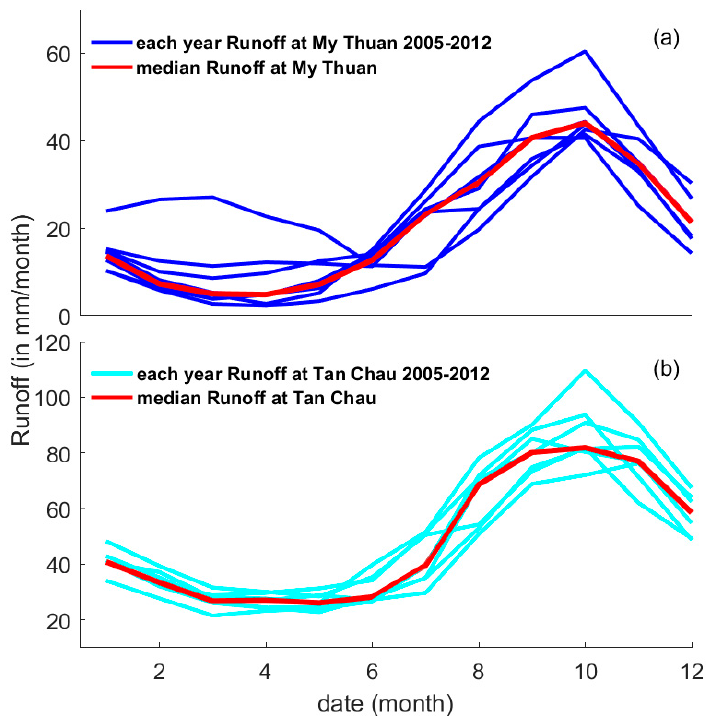
Figure 5. Monthly runoff, from 2005 to 2012, at ( a ) My Thuan, and ( b ) Tan Chau stations.